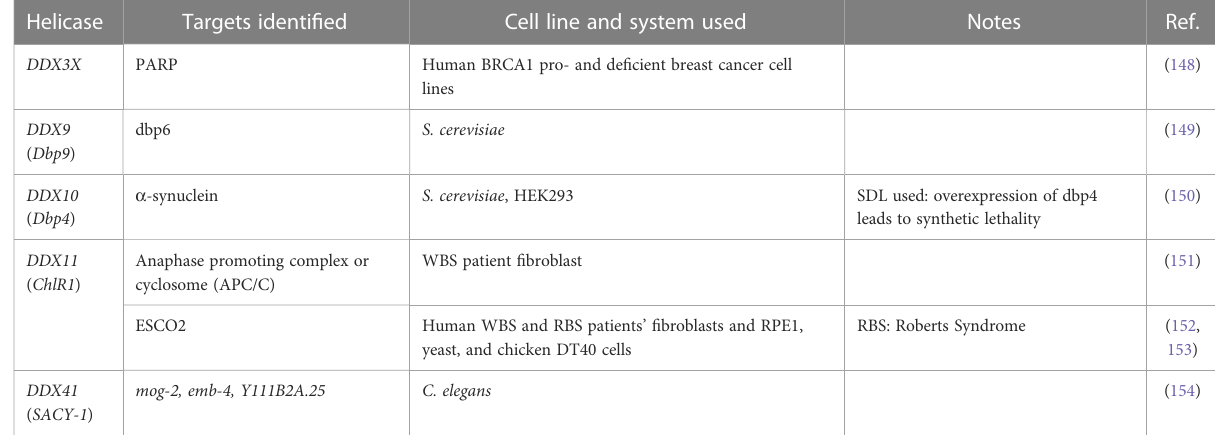
TABLE 2 Synthetic lethality and synthetic dosage lethality interactions of DEAD/H-box helicases.